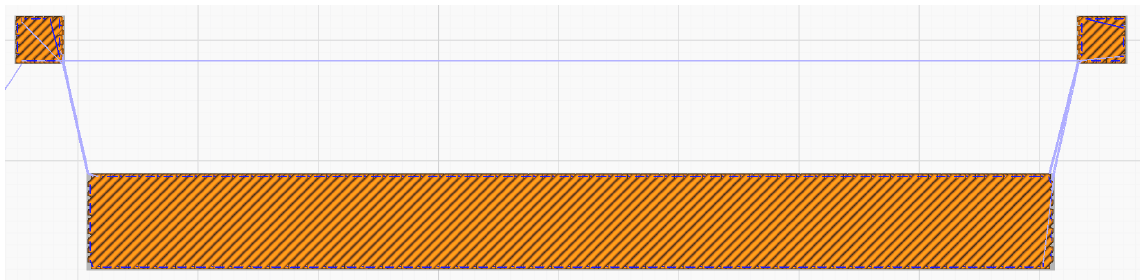
Figure 16. Optimised travel moves on a − 45°/45° stacked specimen with the implementation of auxiliary